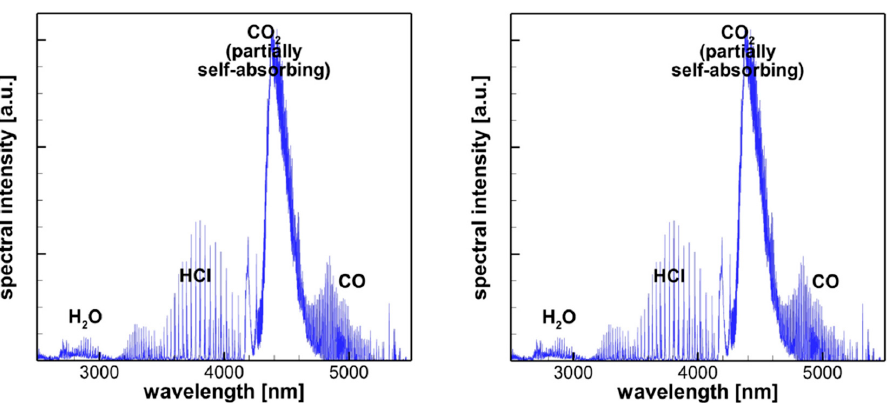
Figure 5. Relation between spectral intensity and wavelength of the rocket exhaust plume (Run031-V06-End). Reprinted with permission from Ref. [28] (2021). V06-End). Reprinted with permission from Ref. [28]